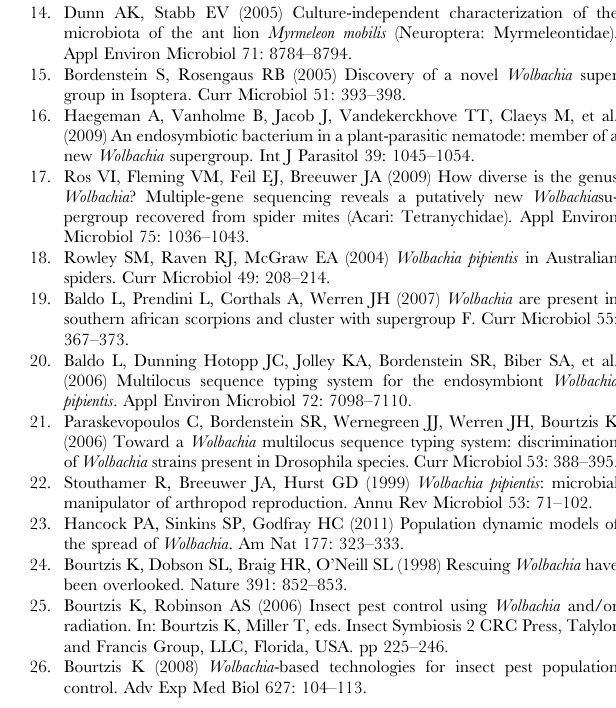
posterior probabilities (top numbers) and ML bootstrap values based on 100 replicates (bottom numbers) are given. (TIF) Figure S5 Bayesian inference phylogeny based on groEL data. The five new Wolbachia strains are indicated with bold letters and the other strains represent supergroups A, B, C, D, F, H, I, K, and L. Strains are designated with the names of their host species, followed by the collection site and the sample name. Bayesian posterior probabilities (top numbers) and ML bootstrap values based on 100 replicates (bottom numbers) are given. (TIF) Table S1 Wolbachia detection of all aphid populations examined in this study, based on 16S rDNA gene sequencing. (DOC) Table S2 Taxonomic details of Wolbachia hosts and accession numbers of analyzed sequences. Table S3 Estimates of Evolutionary Divergence (aver- age) over Sequence Pairs between and within Wolbachia